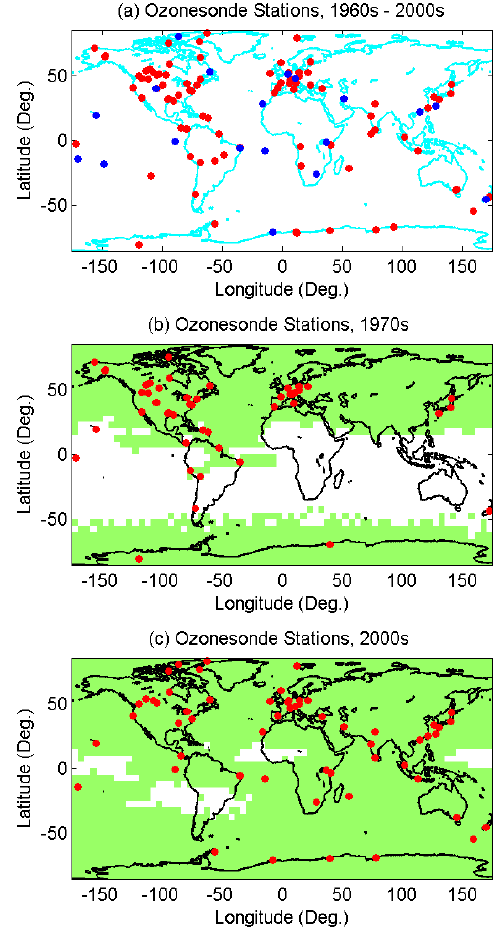
Fig. 1. Global distribution of ozonesonde stations (red and blue dots) used in this study: (a) all stations from the 1960s to the 2000s, (b) in the 1970s, and (c) in the 2000s. Blue dots in (a) indicate stations used for validation (see Table 2). In (b) and (c), the station locations are overlaid with the coverage of ozone climatology (in green) generated in this study at 19.5 km in the 1970s and the 2000s, respectively (see Figure 12 for the ozone values).